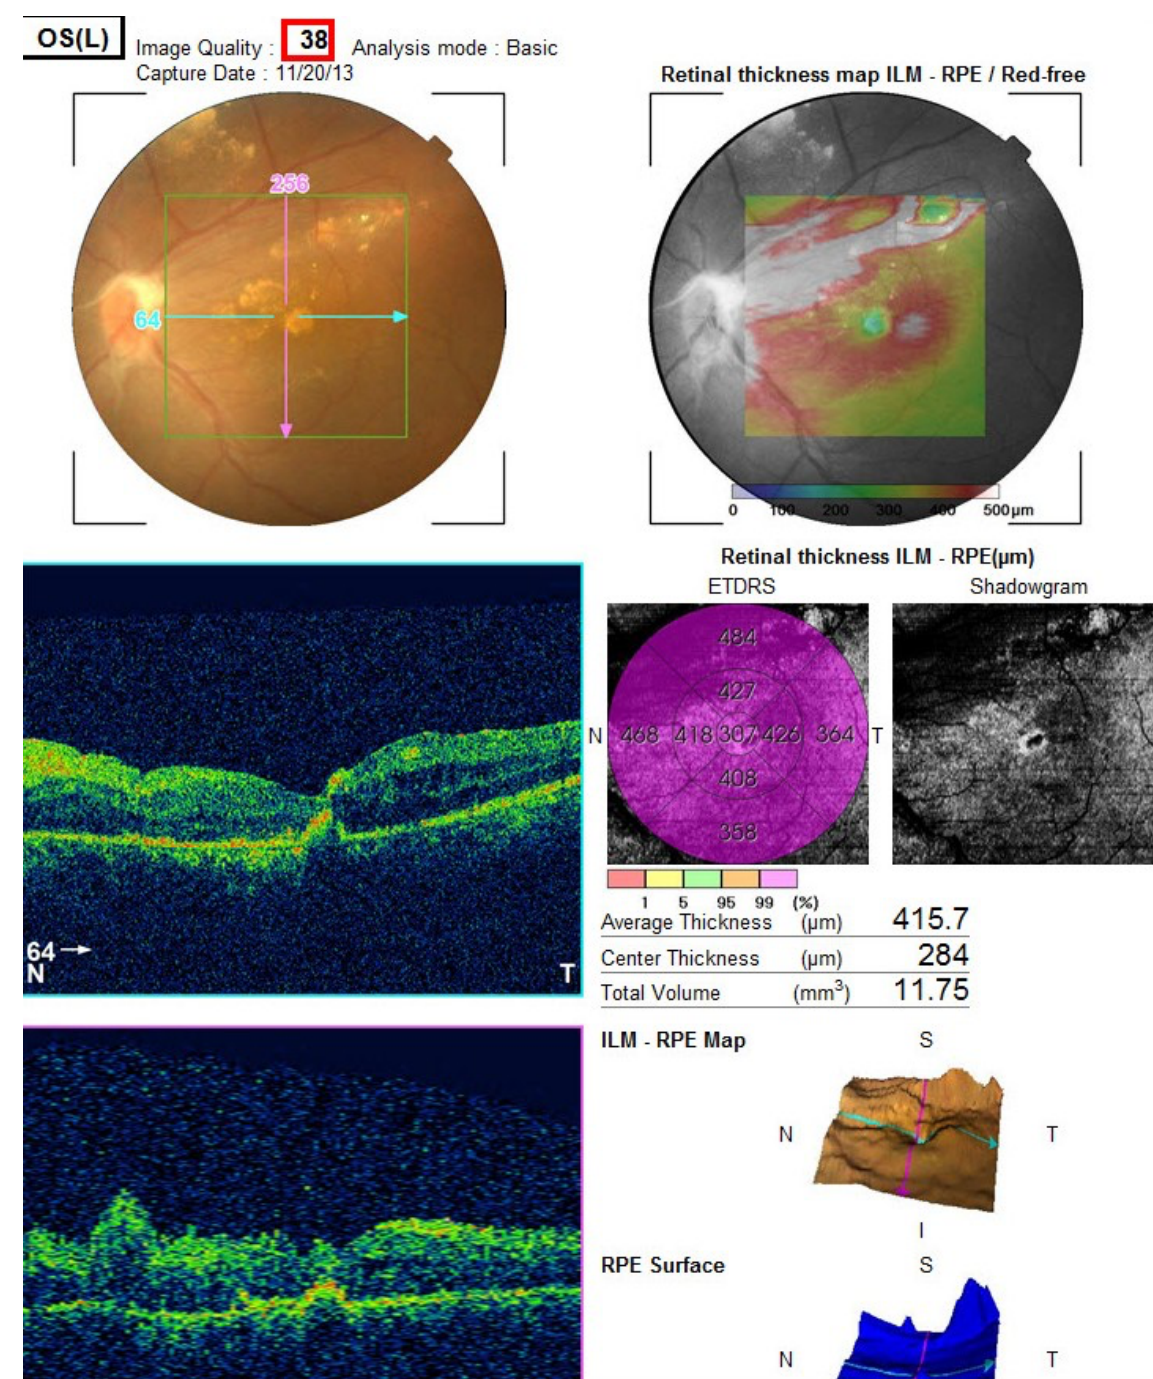
Figure 6: Left eye OCT with macular atrophy and intra and sub retinal hyper-reflective